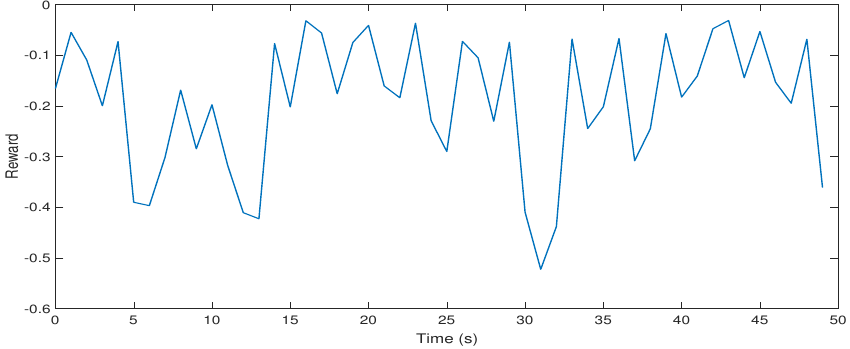
Figure 18. Timing reward for the 20,000 rounds.